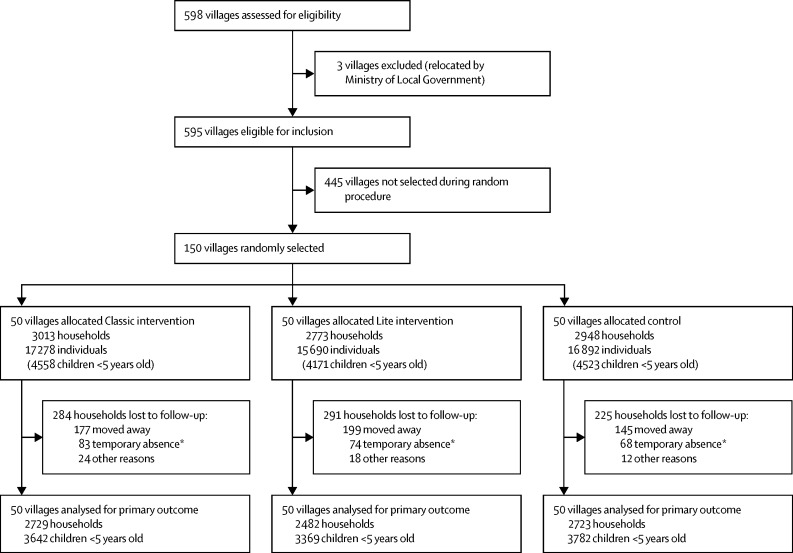
Trial profileNo villages were lost to follow-up. *Temporary absence defined as being unavailable after data collectors visited the household three times in 1 day, with an interval of at least 2 h between each visit.